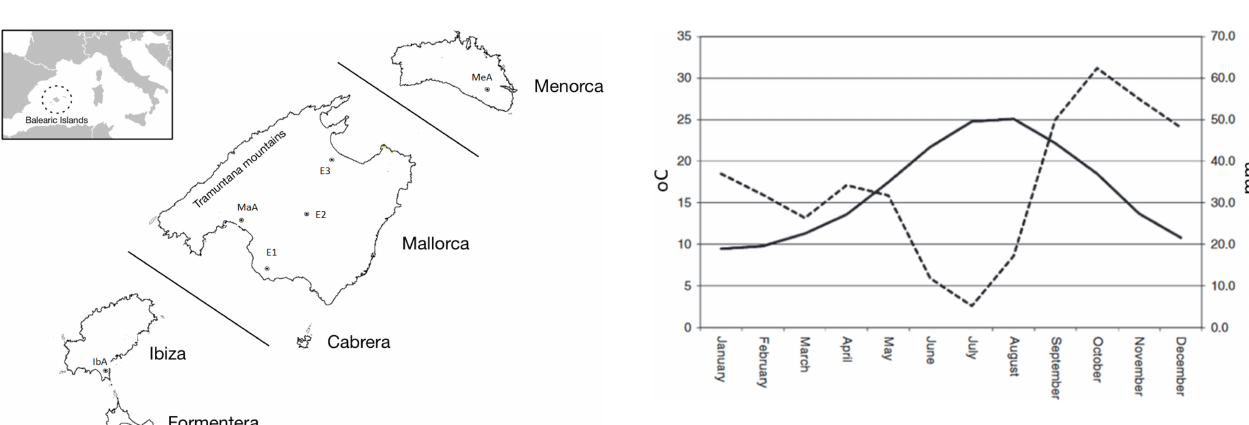
Figure 2. Ombrothermic diagram (Gaussen, 1955) for the Mallorca airport (1981–2010) (after Jansà et al., 2017). The continuous line is the mean temperature. The dashed line is the mean